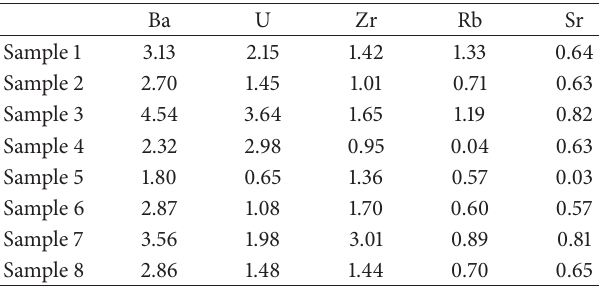
Table 2: Measured concentrations of trace elements in the coastal sediments (mg/kg).